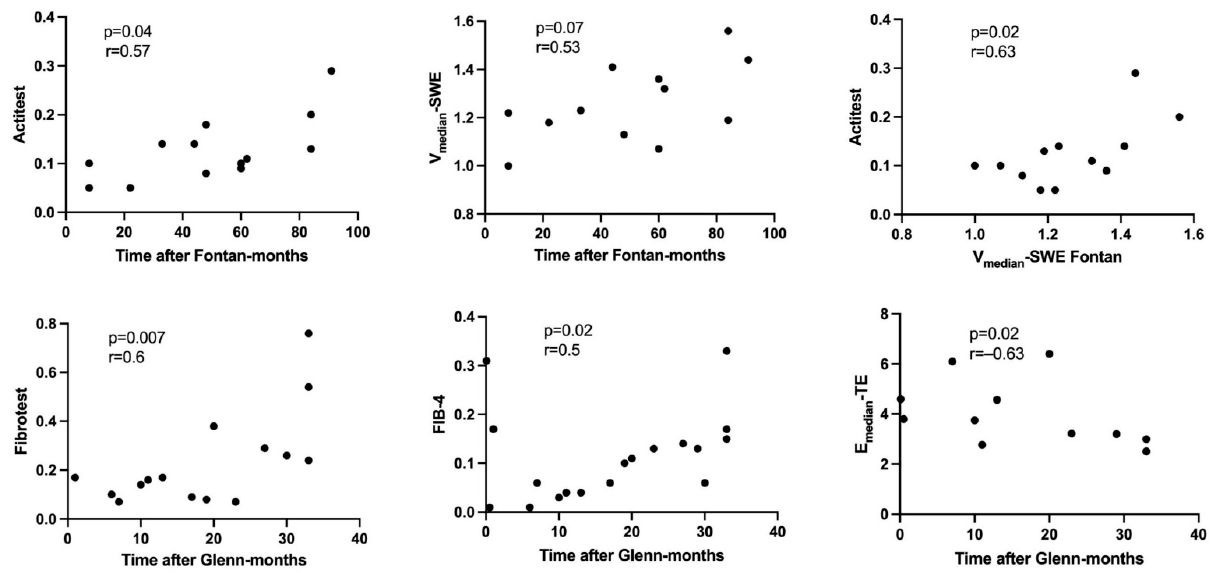
Figure 4. Scatterplot showing correlations between various parameters for Fontan and Glenn pa- tients.